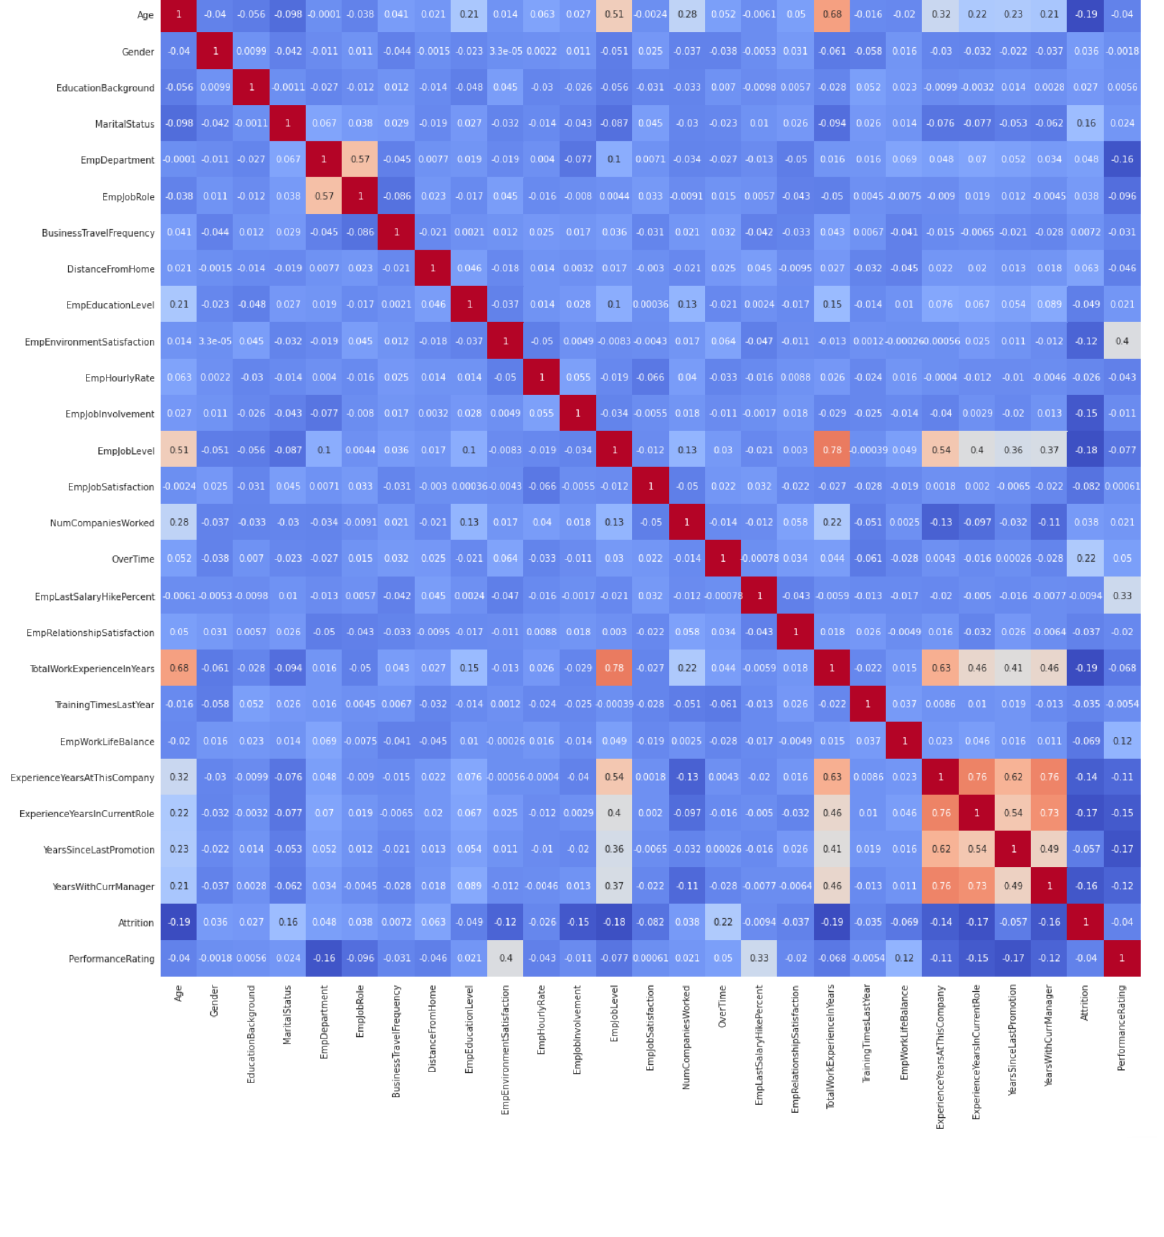
Figure 3. Correlation